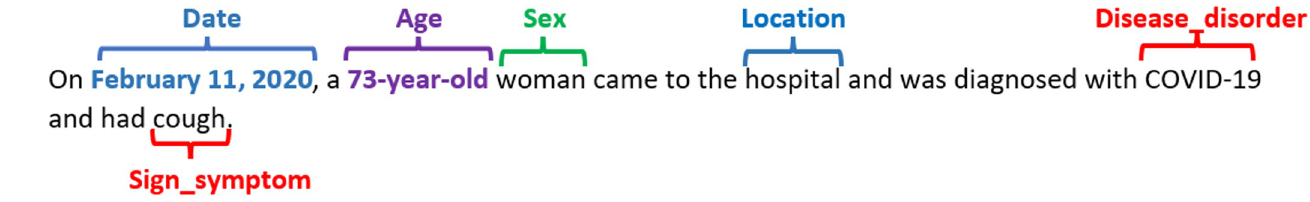
Fig 1. Example of the medical records NER